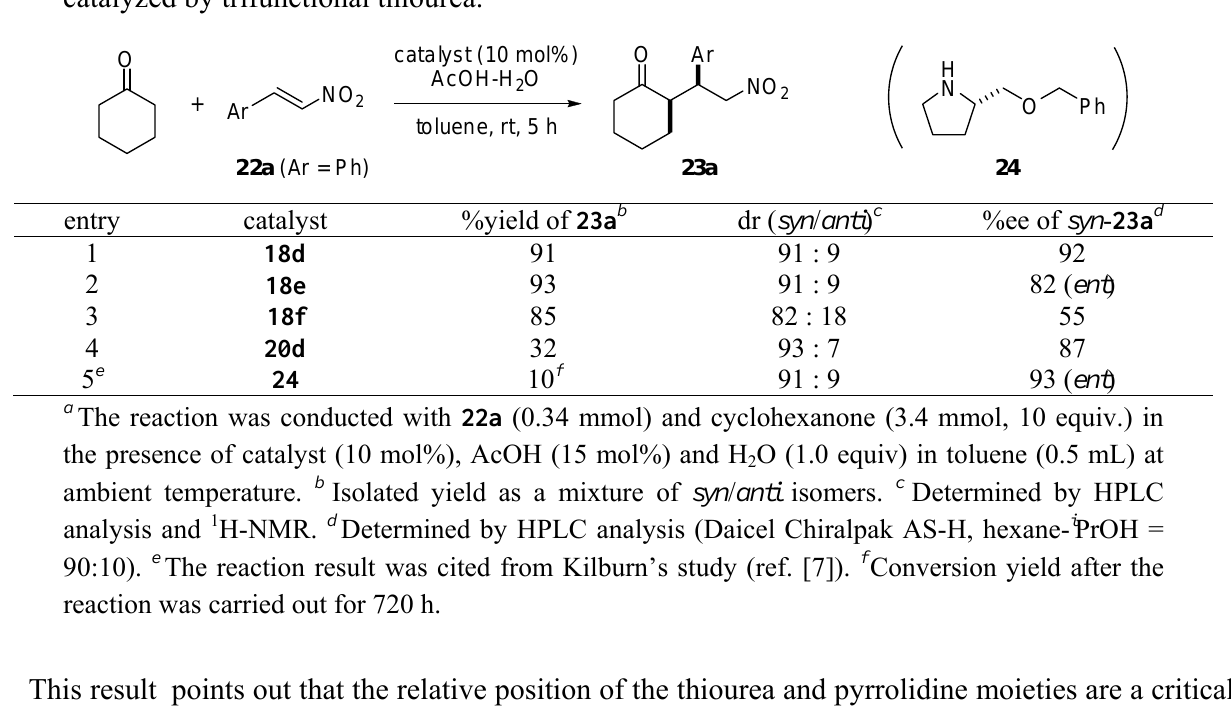
Table 2. Enantioselective conjugate addition of cyclohexanone to trans- β -nitrostyrene catalyzed by trifunctional thiourea.